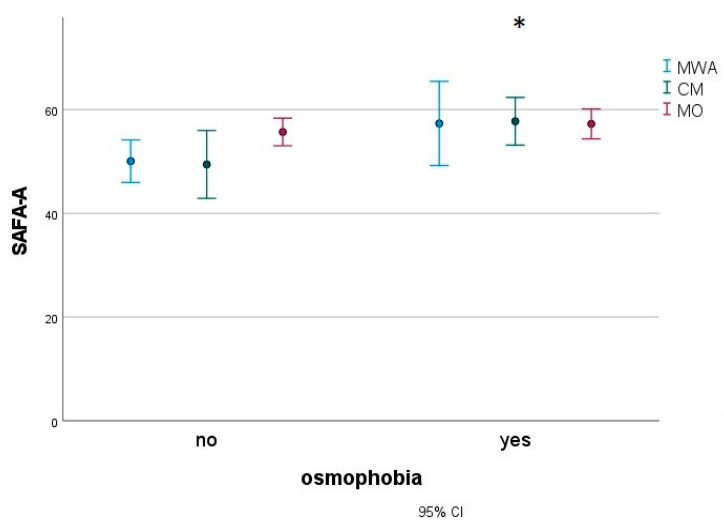
Figure 4. Mean and 95% C.I. of SAFA-Anxiety scores in osmophobic and non-osmophobic migraine children. MWA: migraine with aura; MO: migraine without aura; CM: chronic migraine. Results for osmophobia as a factor * F 4.91, p = 0.028.